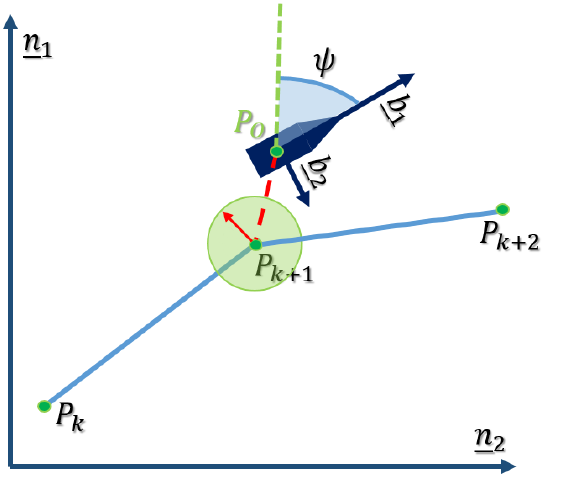
Figure 2. Geometrical sketch of the problem.